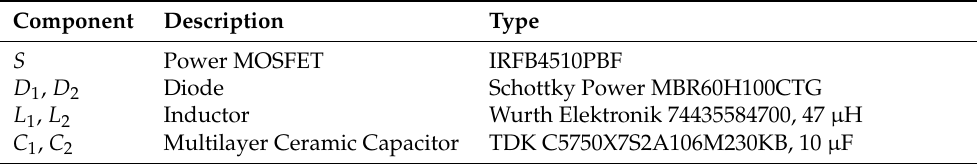
Table 2. Component description of the built prototype.